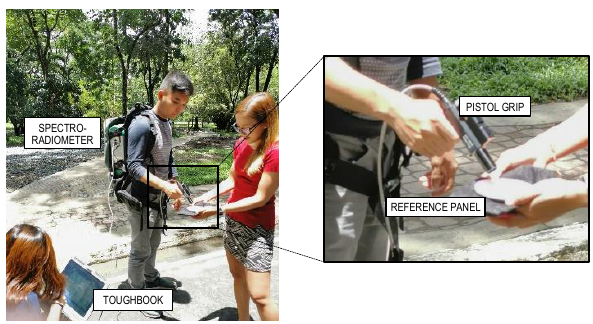
Figure 3. Survey team measuring spectral signature using ASD spectroradiometer